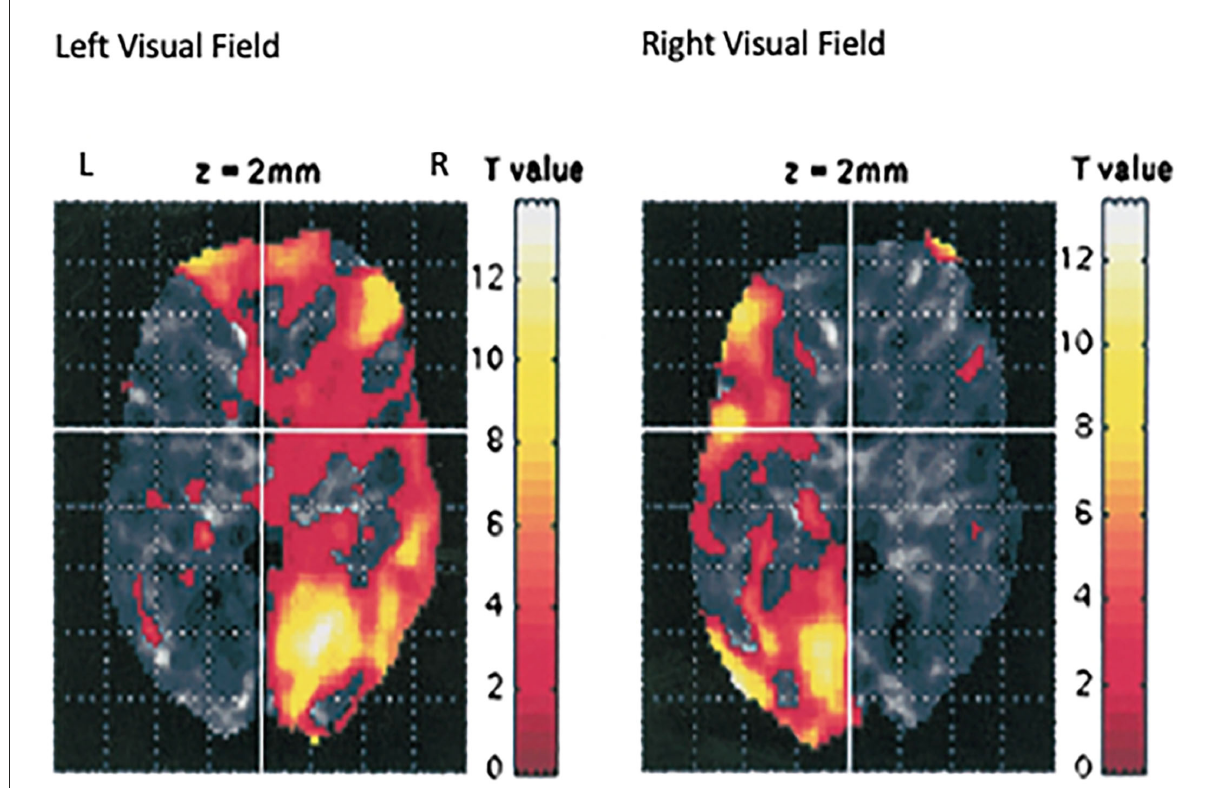
FIGURE2 This is an image of the fMRI data from seven individuals from our laboratory who were using the taped goggles in Figure 1A. in the scanner and were asked to look out of the left lateral visual field for 30s, then 30s out of the right lateral visual field, and then to repeat the protocol. The image represents the data combined for all subjects (Schiffer et al., 2004). Looking out one lateral visual field activates the contralateral